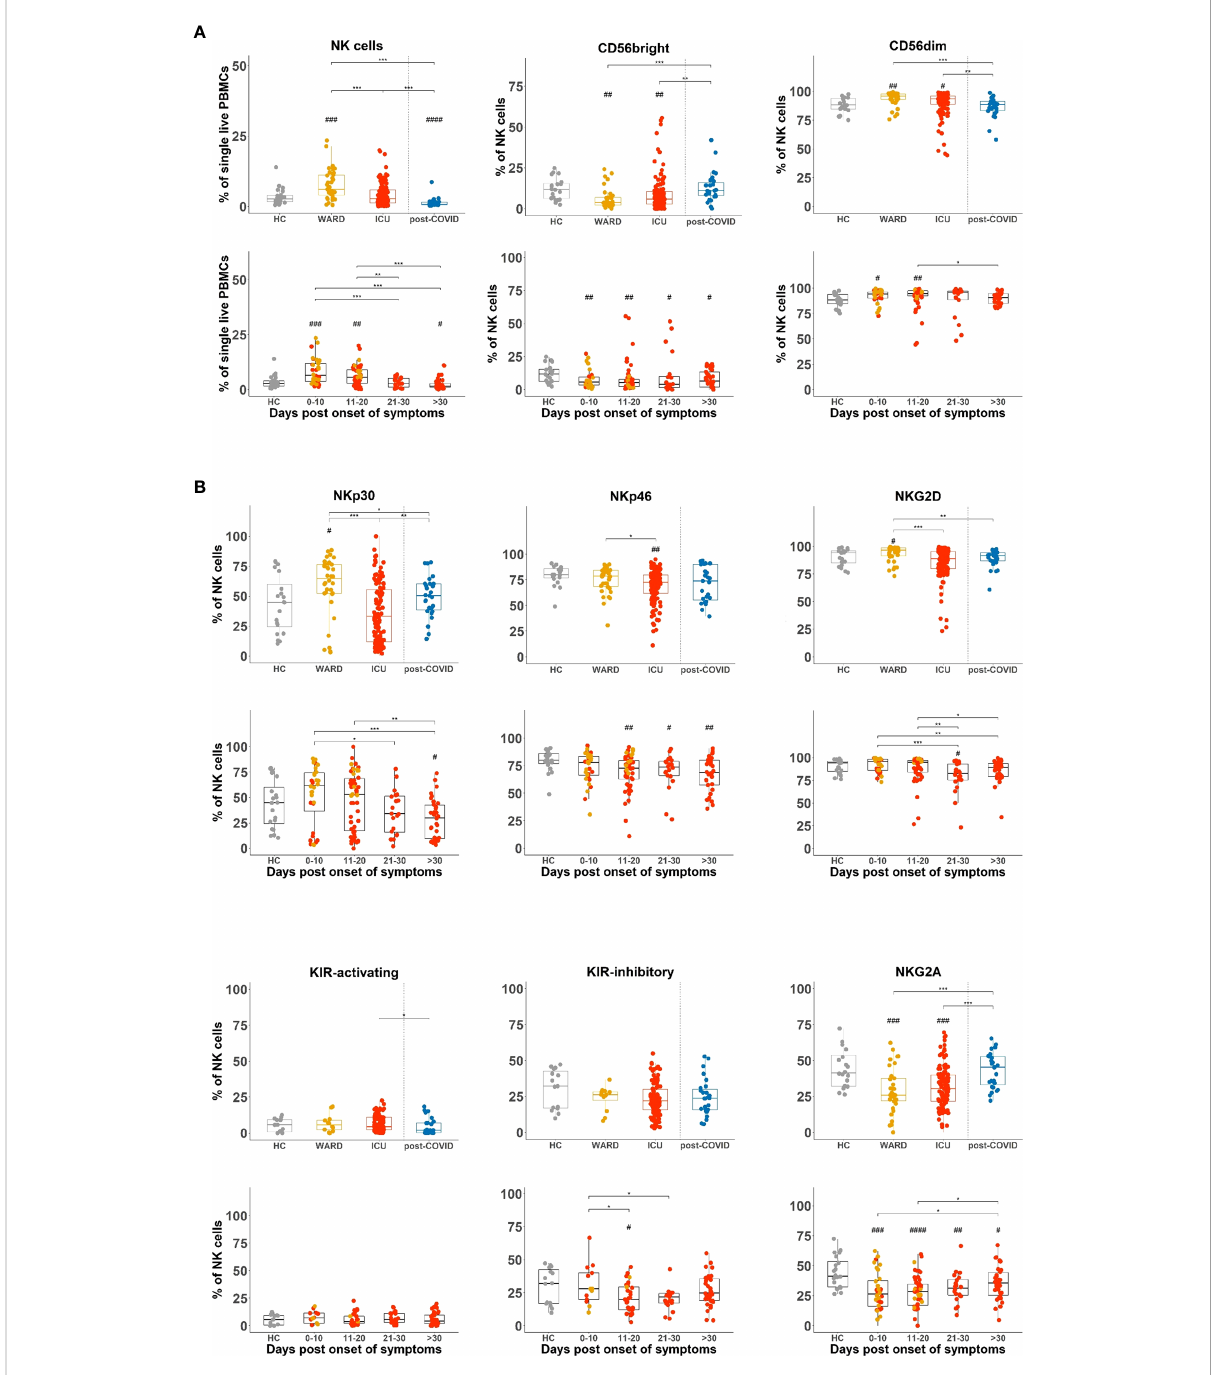
FIGURE 2 Flow cytometry reveals increased frequencies of CD56 dim NK cells in COVID-19 patients at early disease stages and with a different balance of activating and inhibitory NK cell receptors. (A) Percentages of total natural killer (NK) cells and NK cell subsets in peripheral blood mononuclear cells (PBMCs) of healthy controls (HCs) (n = 18), WARD (n = 34), ICU (n = 61), and post-COVID-19 patients (n = 28), upon return to the hospital six weeks after discharge. WARD (yellow) and ICU (red) samples were further subdivided based on the days post onset of COVID-19 symptoms. (B) Percentage expression of activating and inhibitory receptors on total NK cells of indicated experimental groups. Boxplots represent the median and upper and lower quartile, and the whiskers denote the lowest and highest values. Each symbol represents a single patient. For the comparison of groups, p -values were obtained using Wilcoxon signed-rank test with Bonferroni correction. * Represent differences between indicated groups, # represent differences with HCs. */ # p<0.05; **/ ## p<0.01; ***/ ### p<0.001; ####